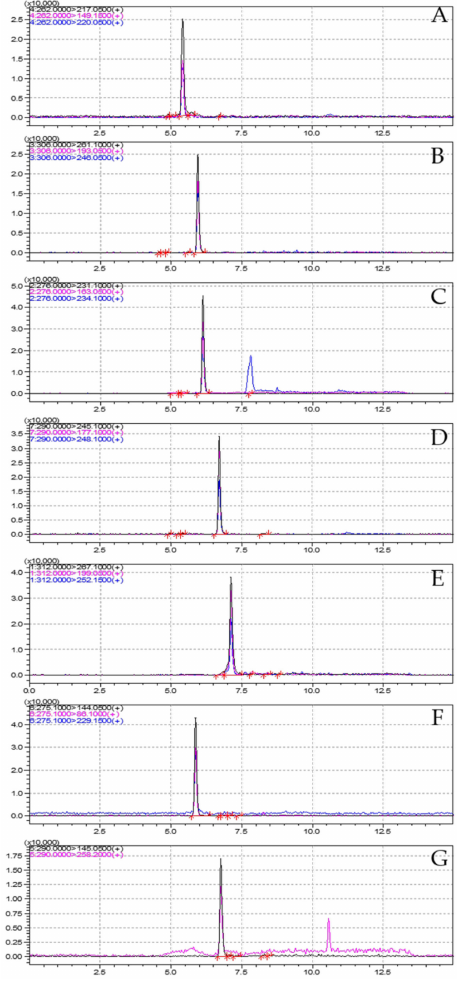
Figure 1. Chromatograms (10 µ g/L) of seven imidazolinone herbicides (( A ): Imazapyr, ( B ): Imazamox, ( C ): Imazapic, ( D ): Imazethapyr, ( E ): Imazaquin, ( F ): Imazamethabenz (free acid), ( G ):